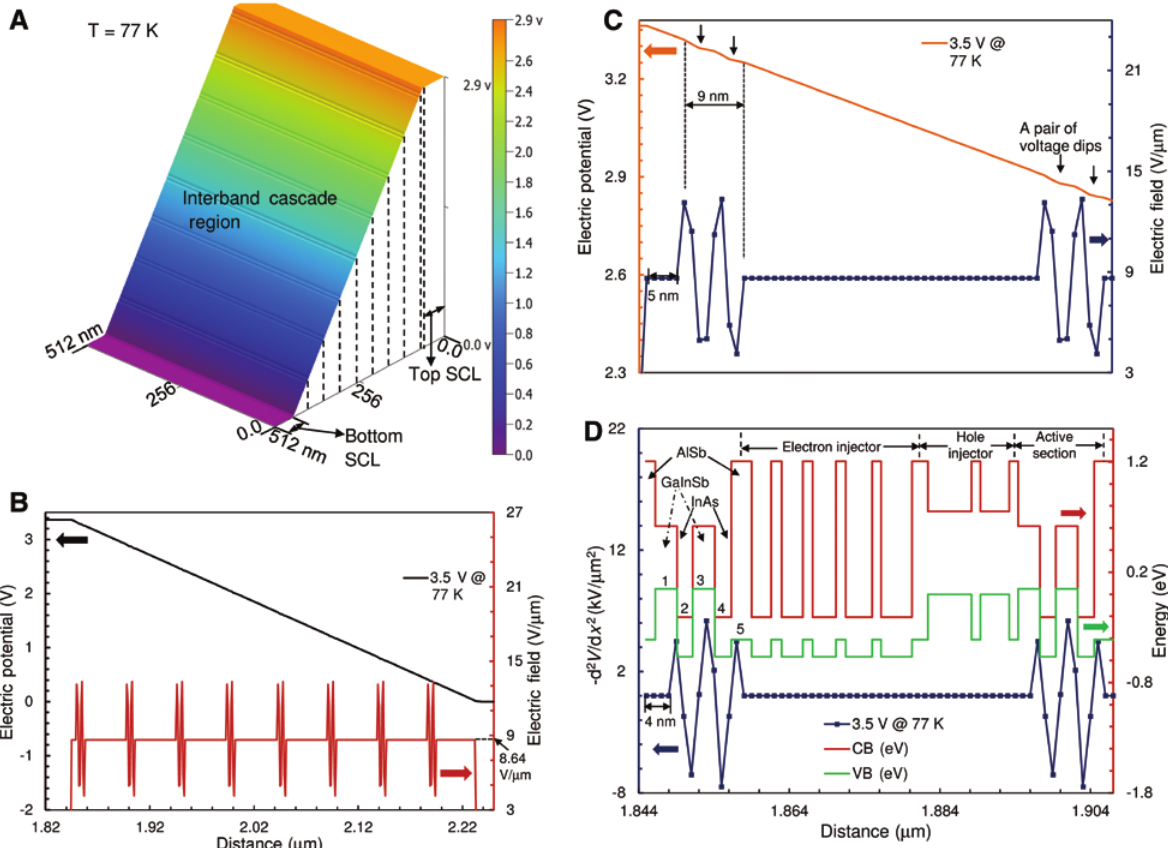
Figure 22: (A) A zoomed-in 2D voltage profile across the interband cascade region (scan area: 512 × 512 nm, temperature: 77 K, and applied bias: 3.0 V). (B) A 1D voltage profile over a distance of 512 nm, together with corresponding electric field (-d V /d x ) distribution across the region. (C) A zoomed-in voltage profile over a distance of 63 nm (temperature: 77 K, device bias: 3.5 V), showing two pairs of voltage dips every ~ 48 nm. The bottom curve shows the corresponding electric field curve. (D) The zoomed-in profile (-d 2 V /d x 2 ) at 3.5 V, numerically derived from the electric field curve (C). The top curve is the zero-bias band diagram of the MQWs in the active